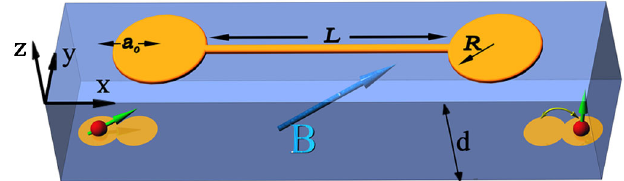
FIG. 1. Model system consisting of two identical double QDs (paired small orange discs) in the x - y plane and the floating gate between them. The gate consists of two metallic discs of radius R connected by a thin wire of length L . Each double QD can accommodate one or two electrons (red spheres), defining the corresponding qubit. Absence of tunneling between the separate double QD is assumed; the purely electrostatic interaction between the electrons in the double QDs leads to an effective qubit, the coupling depends qubit-qubit coupling. For the spin- 1 2 sensitively on the orientation of the magnetic field B . Here, a is 0 the in-plane distance between a QD and the corresponding disc’s center, while d is the vertical distance between the QD and the